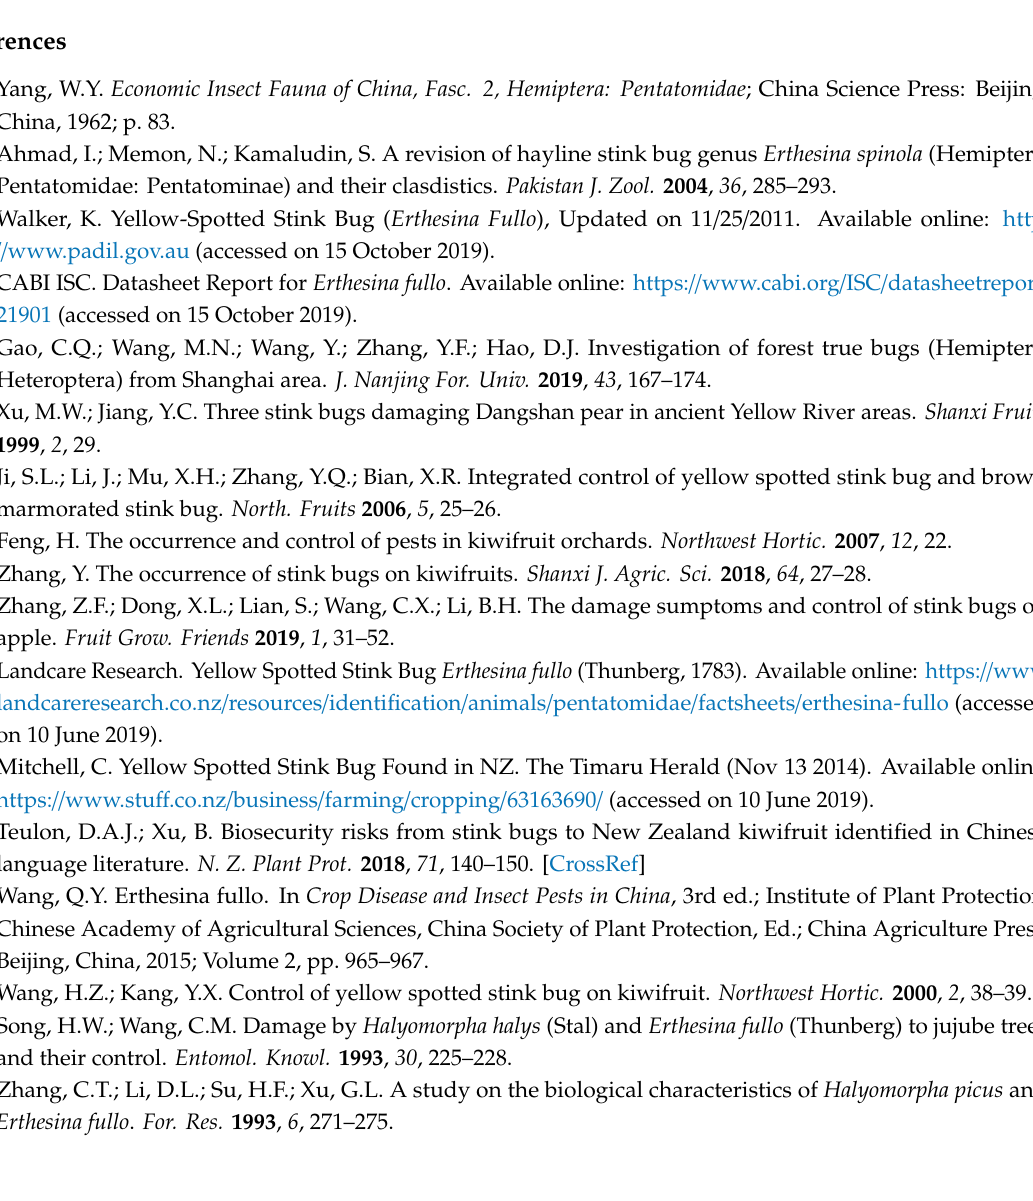
Table S1: Literature searches for the yellow spotted stink bug, Erthesina fullo , in Chinese and English. Figure S1: Number of publications on Erthesina fullo published by decade in Chinese and